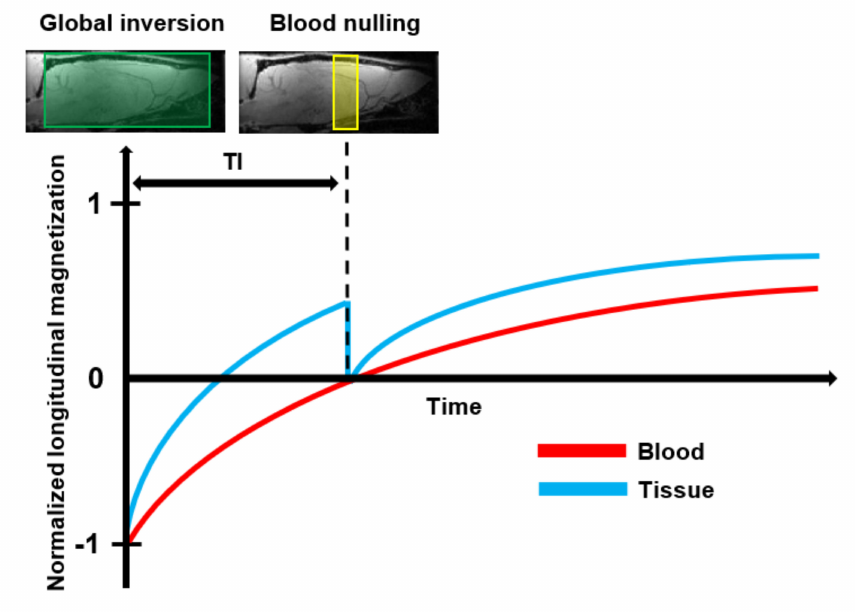
Figure 6. Schematic representation of the basic principle of Vascular Space Occupancy (VASO) MRI: First, the spins of both blood and tissue are inverted by the use of a spatially non-slice-selective global 180 ◦ inversion pulse. After the global inversion pulse, the longitudinal magnetization of blood and tissue relax back at their spin-specific T1 relaxation rate. At the optimal Inversion Time (TI), when the longitudinal magnetization of the tissue crosses zero, an additional 90 ◦ excitation pulse is applied to null the blood signal. Then, an image is acquired that contains only signals that arise from the extravascular